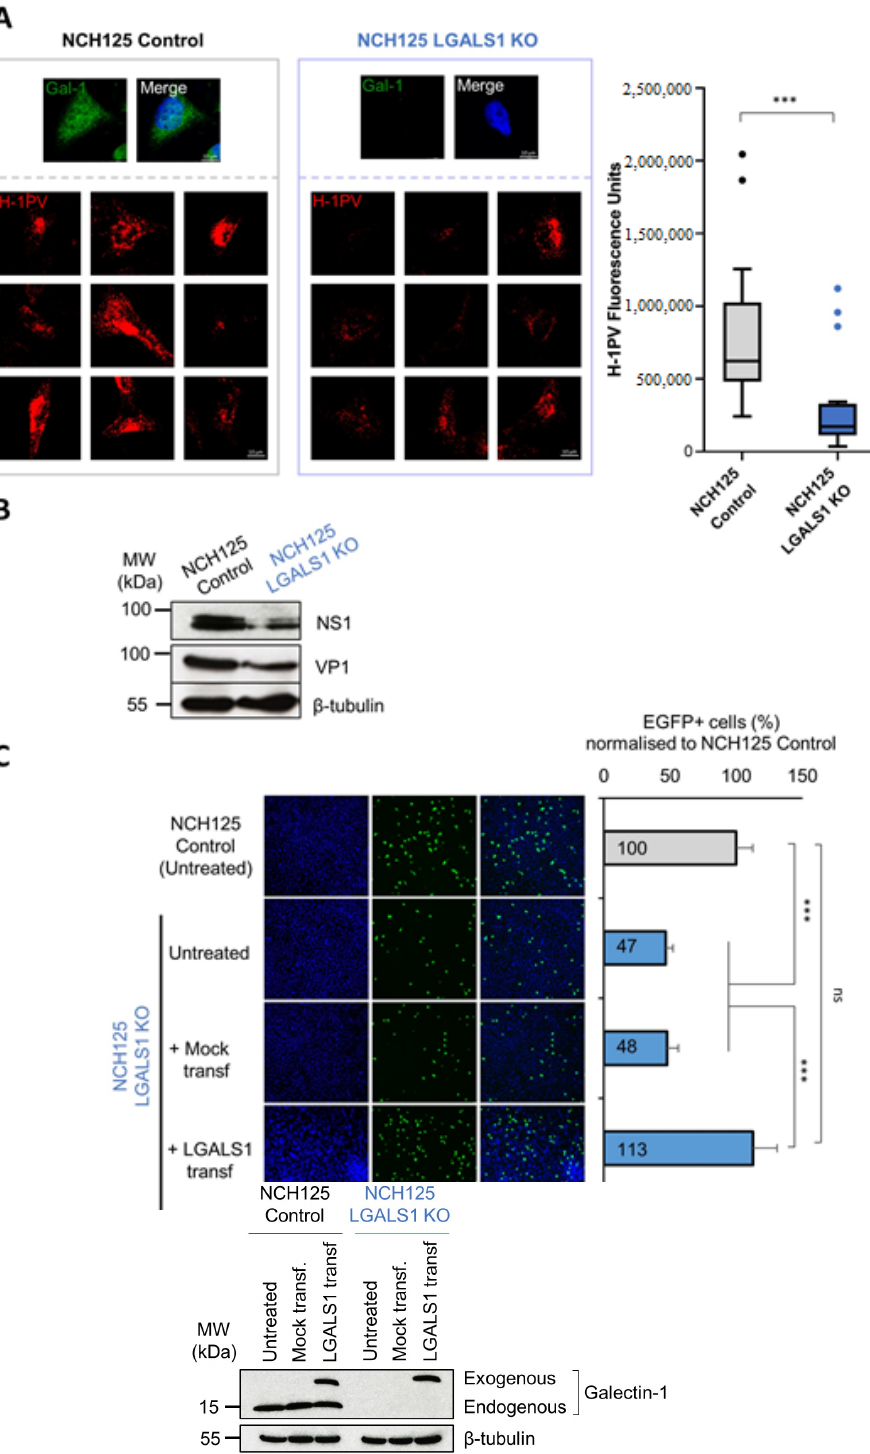
Figure 3. H-1PV infectivity is reduced in NCH125 LGALS1 KO cells. ( A ) H-1PV entry decreases in NCH125 LGALS1 KO cells. Control and LGALS1 KO cells were infected with H-1PV at an MOI of 50 pfu/cell for 2 h at 37 ◦ C and prepared for confocal microscopy analysis. Gal-1 (green) and